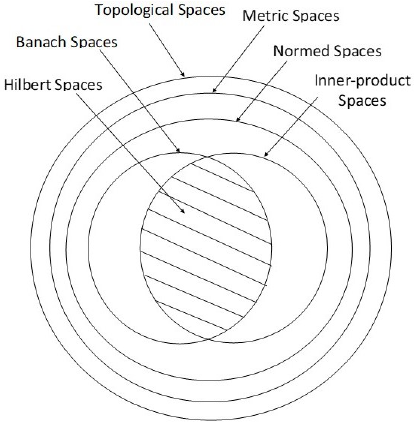
Figure 1. Relationship among different spaces in functional